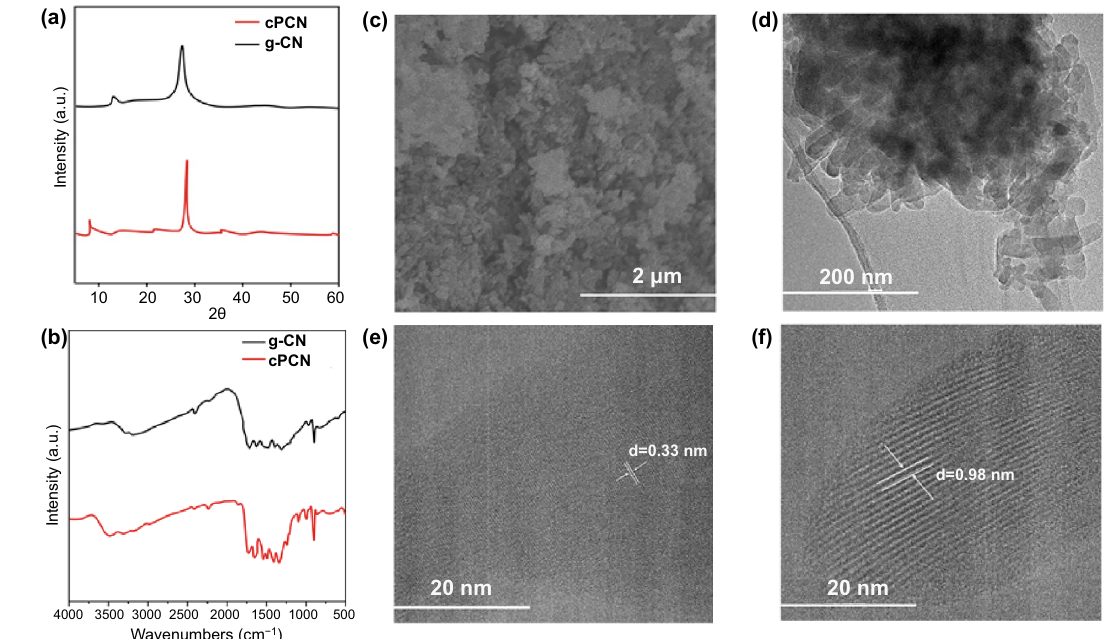
Fig. 1 a , b XRD patterns and FTIR spectra of cPCN and g-CN. c SEM images and d TEM images of cPCN. e, f HRTEM images for